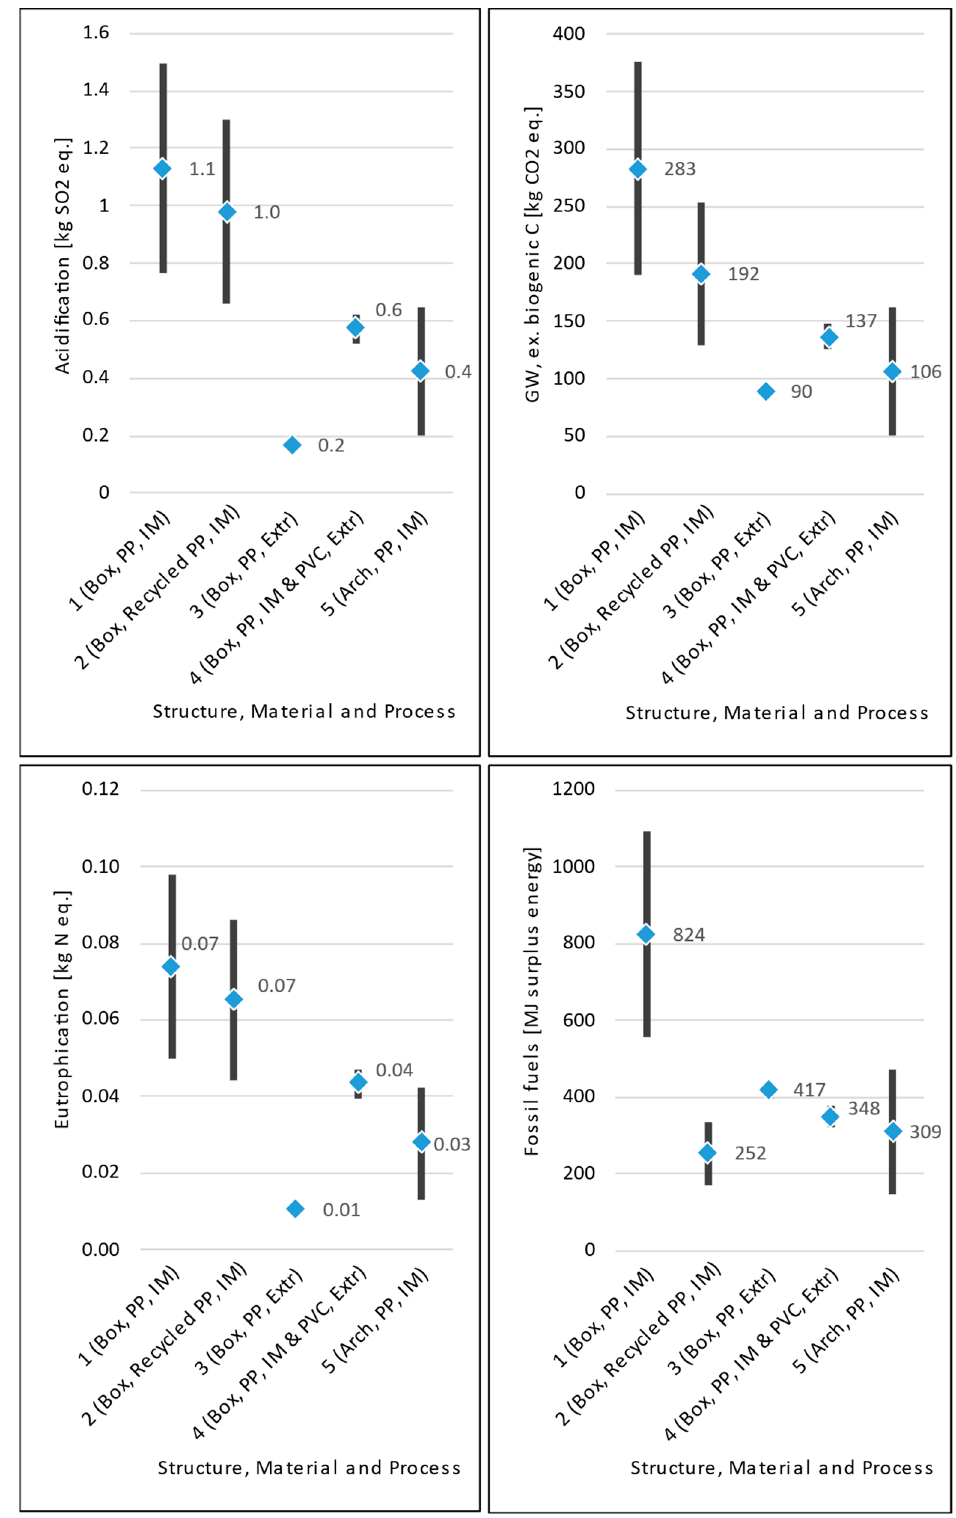
Figure 4. Traci 2.1 midpoint impact of plastic material and process choice showing the injection- molded polypropylene box having the greatest impact. Diamonds represent the midpoint, and the black bars represent the range.